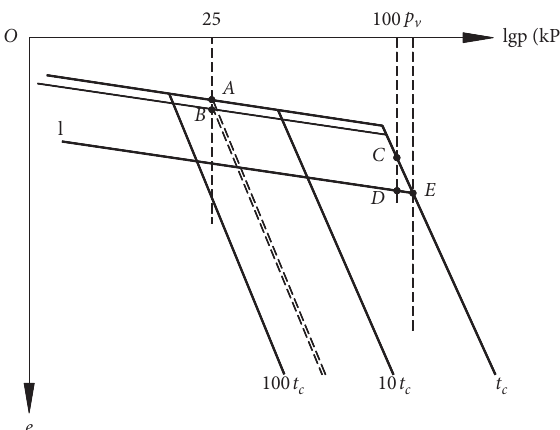
Figure 9: Bjerrum’s equitime e − lg p